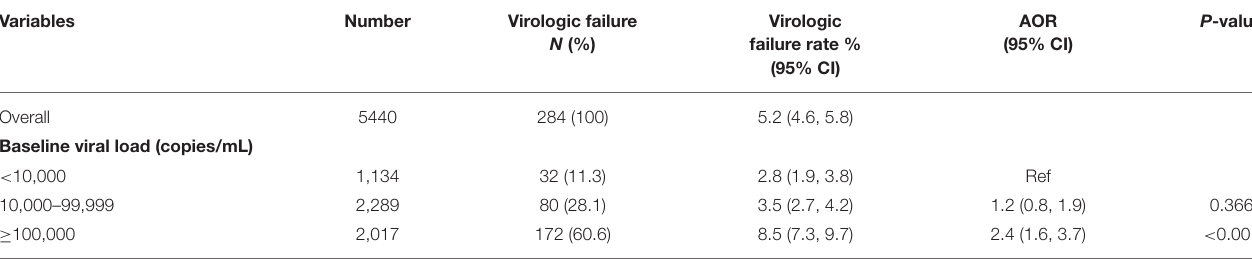
TABLE 3 | Effects of baseline viral load on virologic failure at 12 months among HIV patients initiating ART in Chongqing, China, 2015–2019. Variables